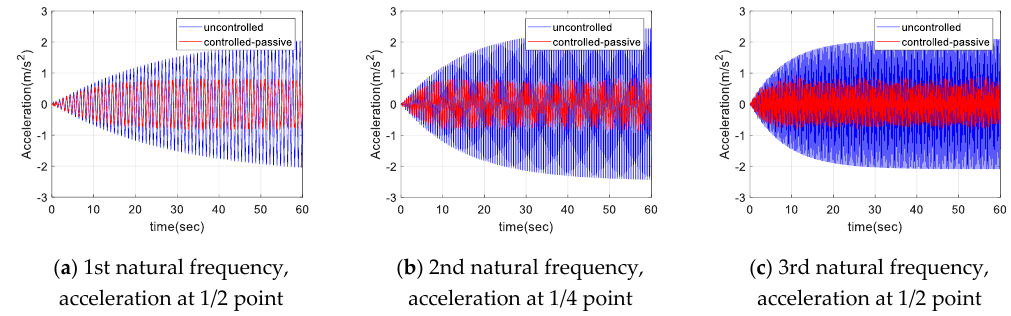
Figure 11. Acceleration response of the cable for sinusoidal input.